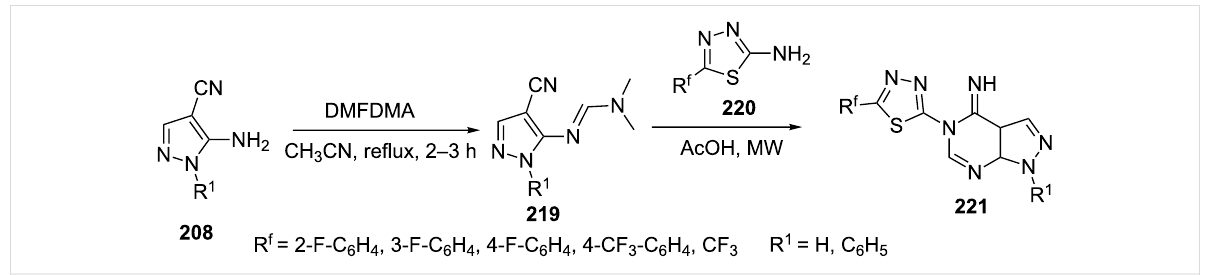
Scheme 59: Synthesis of 5-(1,3,4-thidiazol-2-yl)pyrazolo[3,4- d ]pyrimidine.